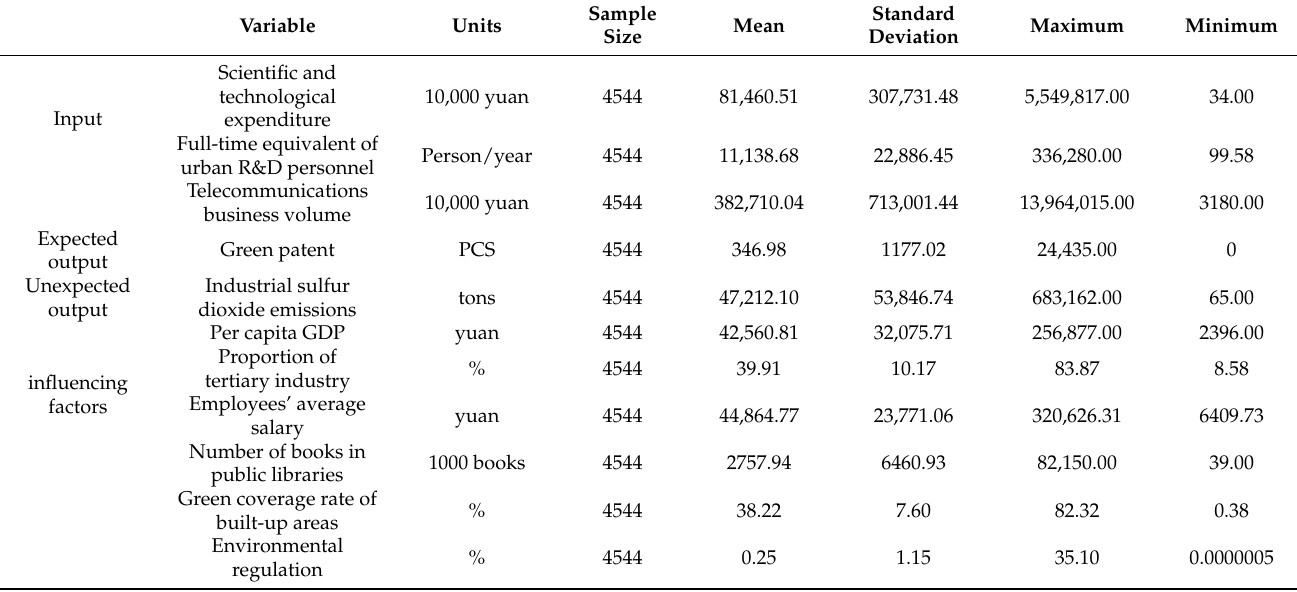
Table 1. Statistics describing the data.